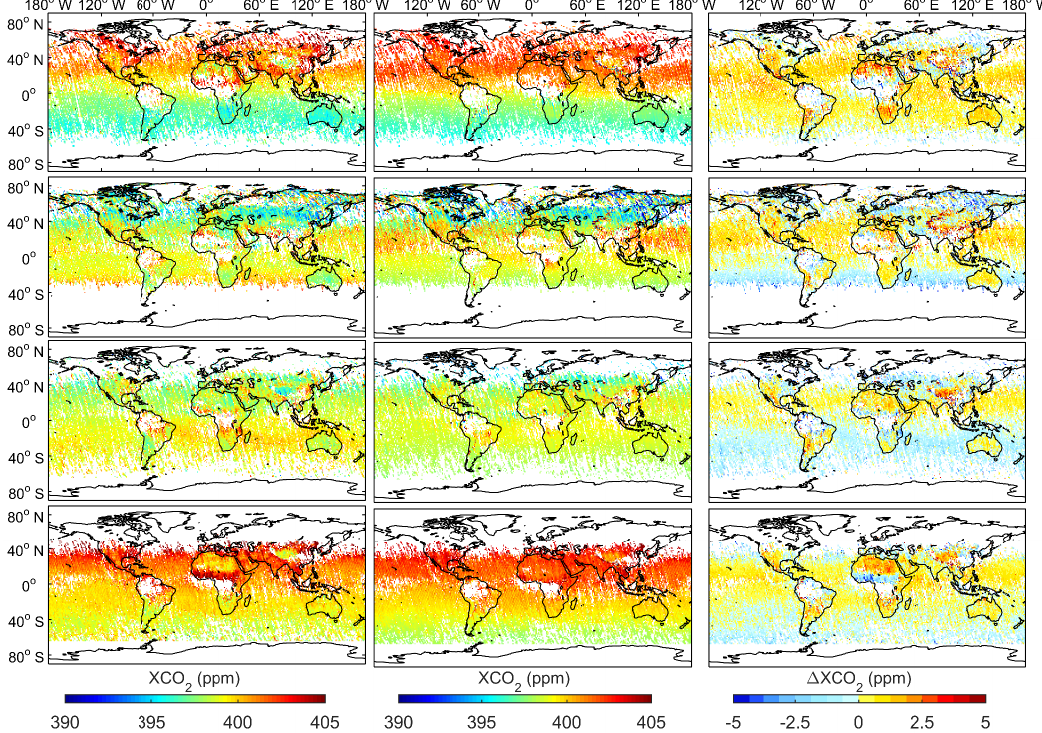
Figure 14. Global distribution of the OCO-2 XCO 2 (left panel), CT2017-modeled XCO 2 (middle panel) and the differences between the CT2017 XCO 2 and OCO-2 XCO 2 (right panel; ∆ XCO 2 =XCO 2 _CT − XCO 2 _OCO-2). Each row of panels, from top to bottom, subsequently represents spring, summer, autumn and